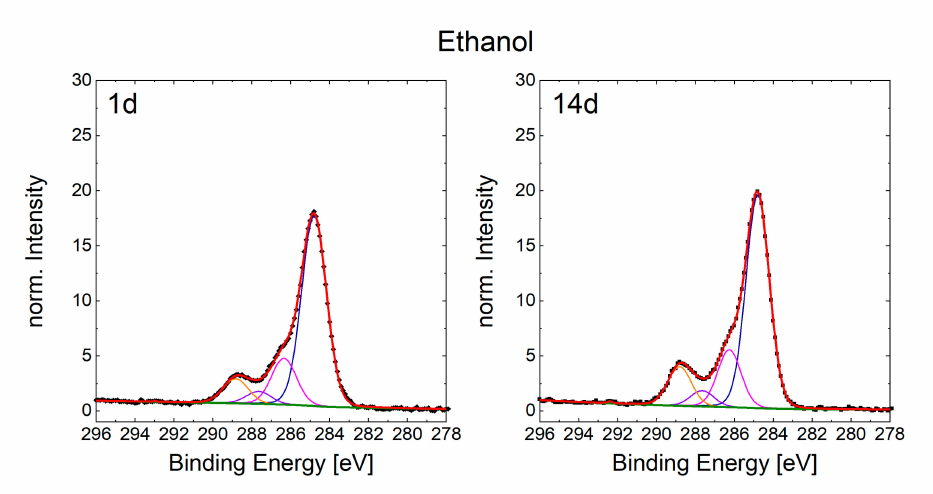
Figure A2. C 1s spectra of structured sample 1 and 14 days after cleaning with ethanol.